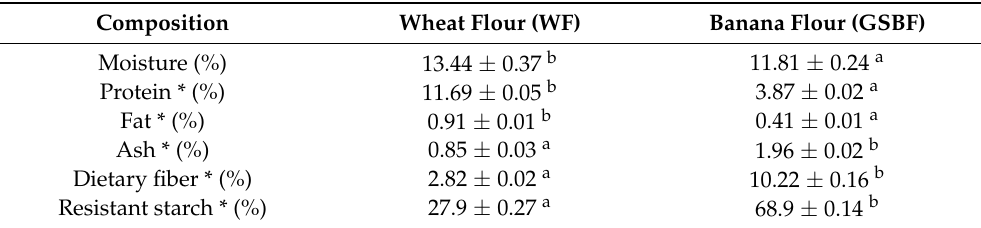
Table 2. Chemical compositions of commercial wheat flour and green Saba banana flour.